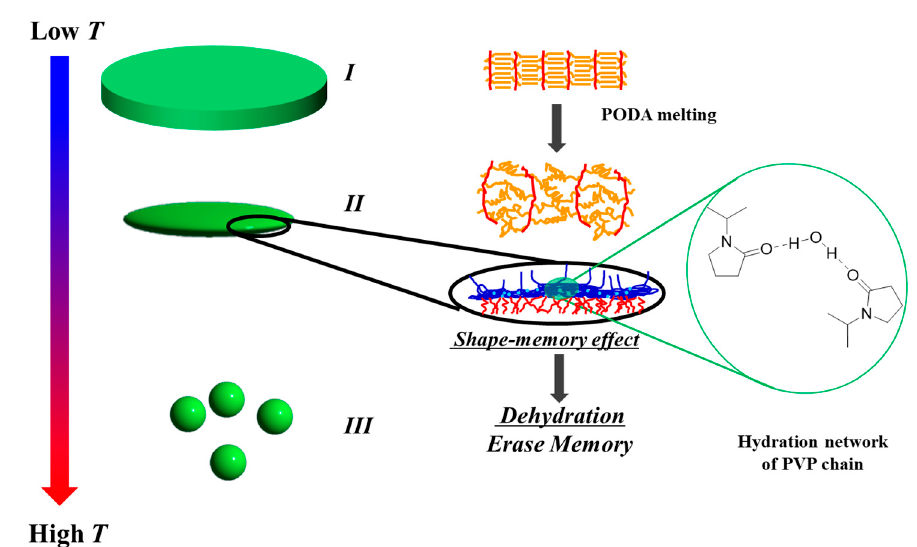
Figure 5. Schematic illustration of molecular mechanism of two-step temperature responsiveness of PVP- b -PODA micelles in heating process.